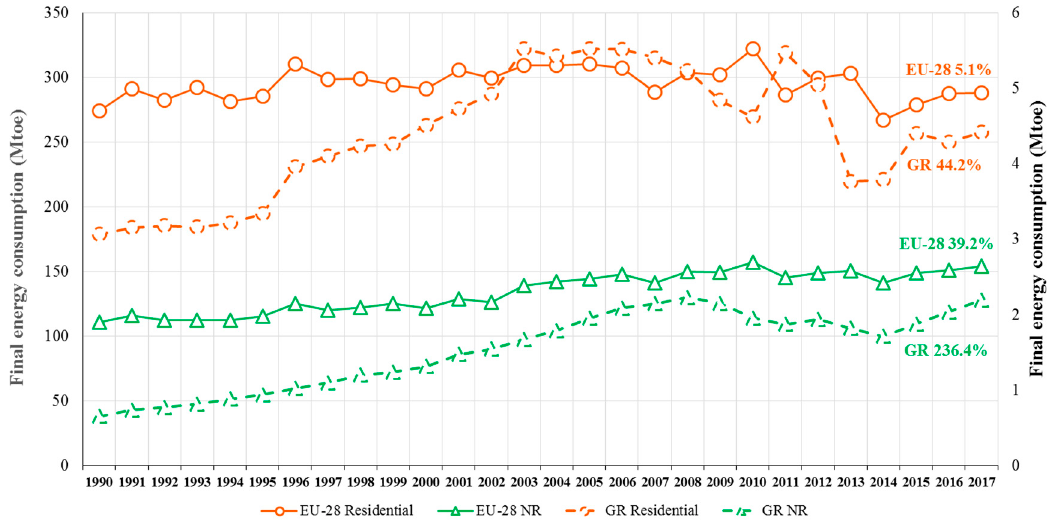
Figure 1. Time evolution of final energy consumption in residential (circles) and nonresidential (NR) (triangles) buildings for EU-28 (solid line, primary axis) and Greece (dashed line, secondary axis). The percentages refer to the corresponding increase of the final consumption in 2017 compared to 1990. (Data source [3]).